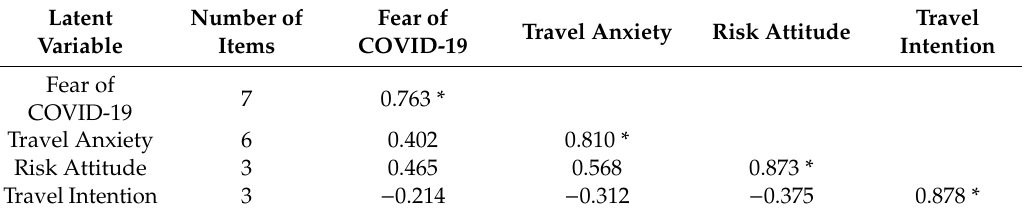
Table 3. Latent Variable Correlation Coe ffi cients.